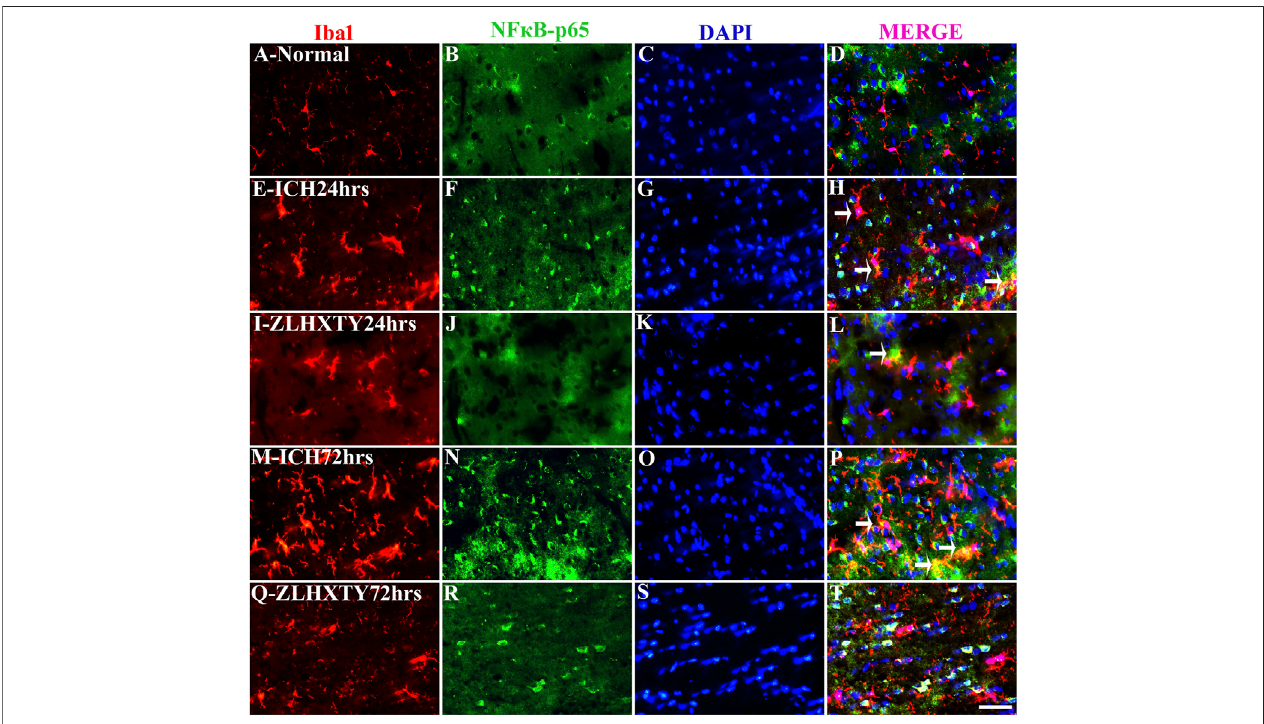
FIGURE 9 | Double Immuno fl uorescence staining of Iba1 and NF κ B-p65. Brain sections were triple-stained with anti-Iba1 (red), anti-NF κ B-p65 (green) and DAPI (blue) to mark microglia, NF κ B-p65 and nucleus. (A – D) , Normal brain section shows very few Iba1 stained glial cells and absence of NF κ B-p65. (E – H) , ICH 24 h group show increased number and activation of Iba1 positive glial cells with a lot of projections and also increased NF κ B-p65 expression but only few co-localization signals were found. (I – L) , ZLHXTY 24 h group shows decreased Iba1 activation and also negligible NF κ B-p65 expression and very little co-localization signal was detected. (M – P) ,ICH72 hshowimmense activationofIba1stainedglialcellsandalso NF κ B-p65expression and moreco-localization signalsascompared toICH 24 h group. (Q – T) , ZLHXTY 72 h group show marked reduction in Iba1 and NF κ B-p65 expression. Respective change in color in merged fi gures D,H,L,P,T, corresponds to Red + Blue = Magenta; Red + Green = Yellow. 50 µm scale bar corresponds to 400 × magni fi cation.